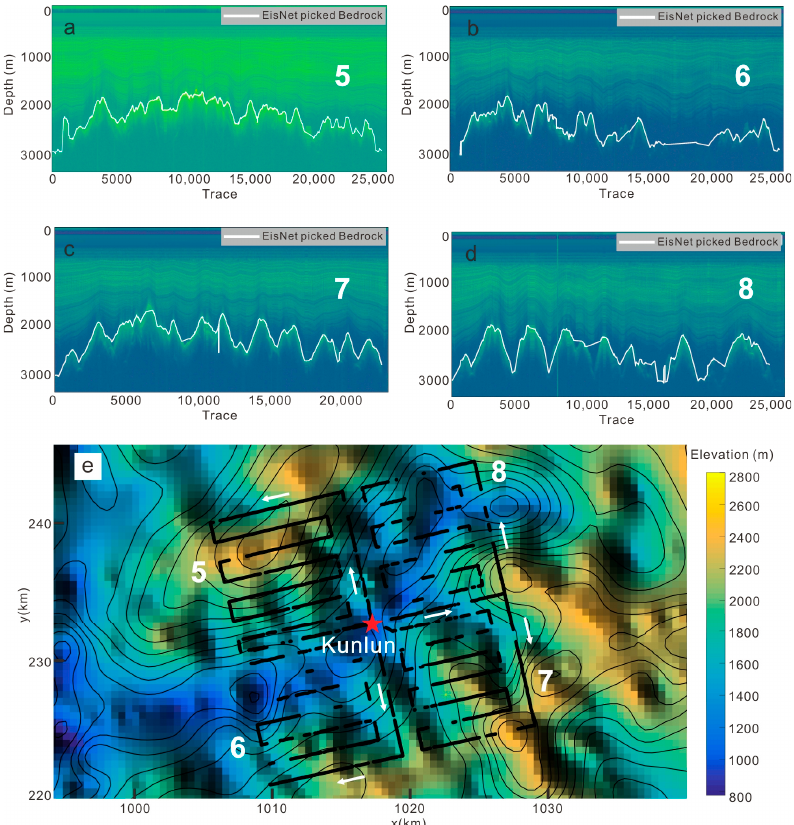
Figure 2. ( a – d ). Radar profiles of CHINARE 29; white lines show the ice–bedrock interfaces extracted by EisNet; ( e ) the positions of extracted results around the drilling site at Kunlun Station in the Dome A region (white arrows represent the direction of the radar